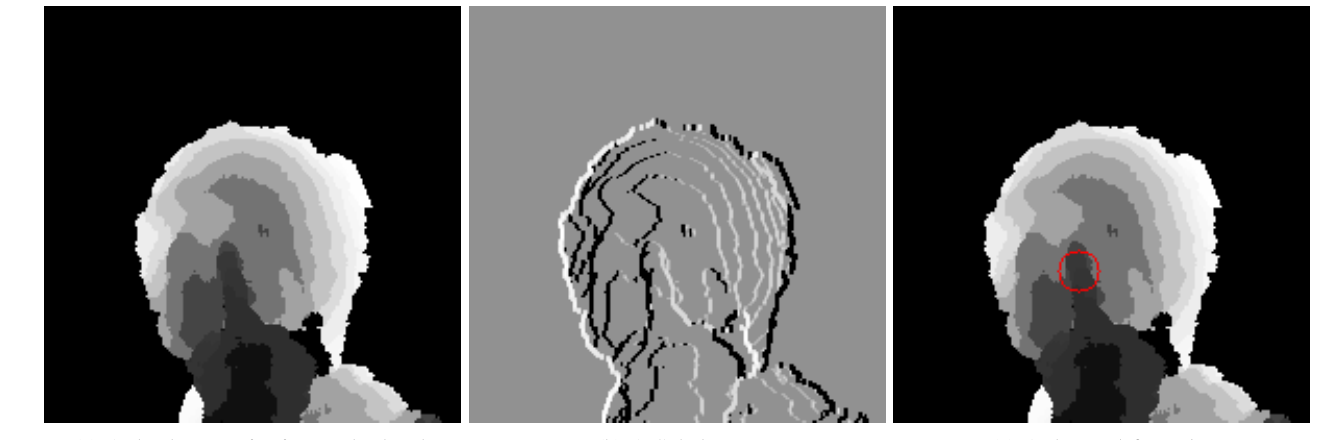
Fig. 11. Fingertip detection.